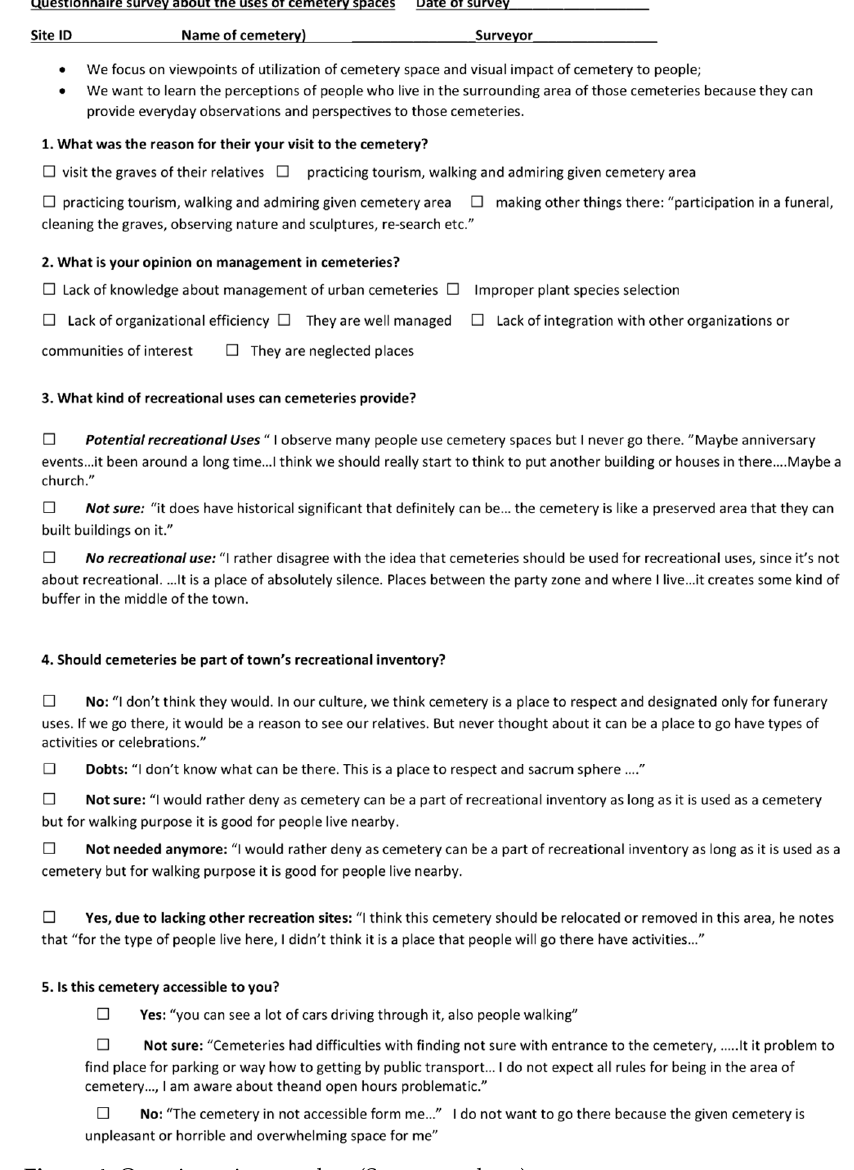
Figure 4. Questionnaire template (Source: authors).